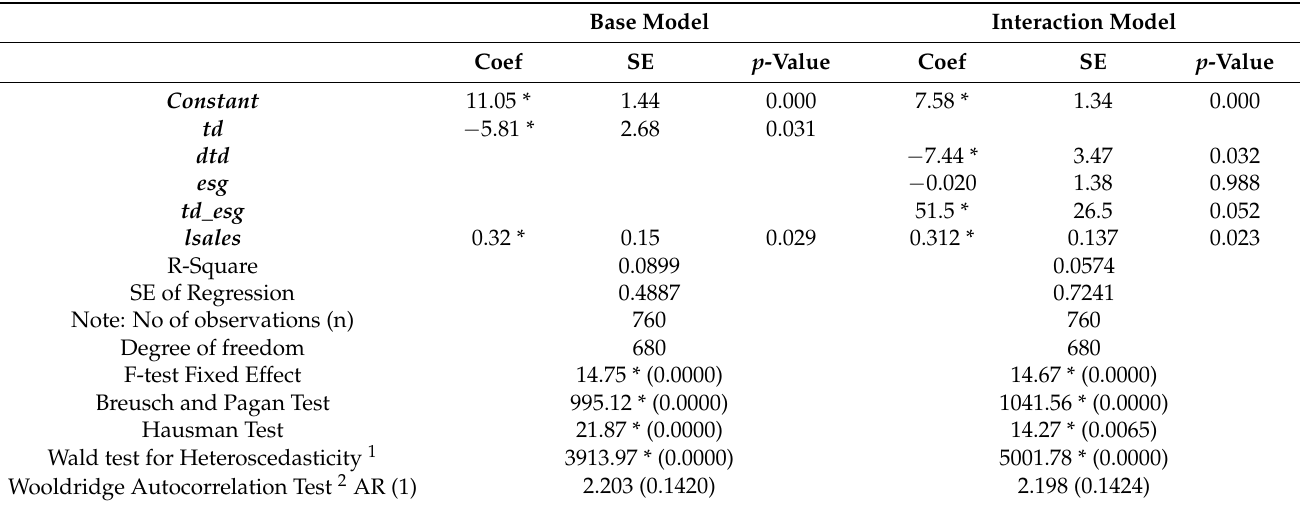
Table 3. Result of Regression Analysis (Static Panel Data